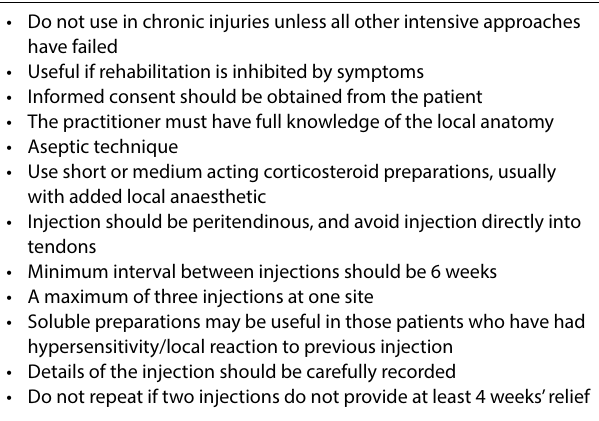
Guidelines for use of local steroid injections in